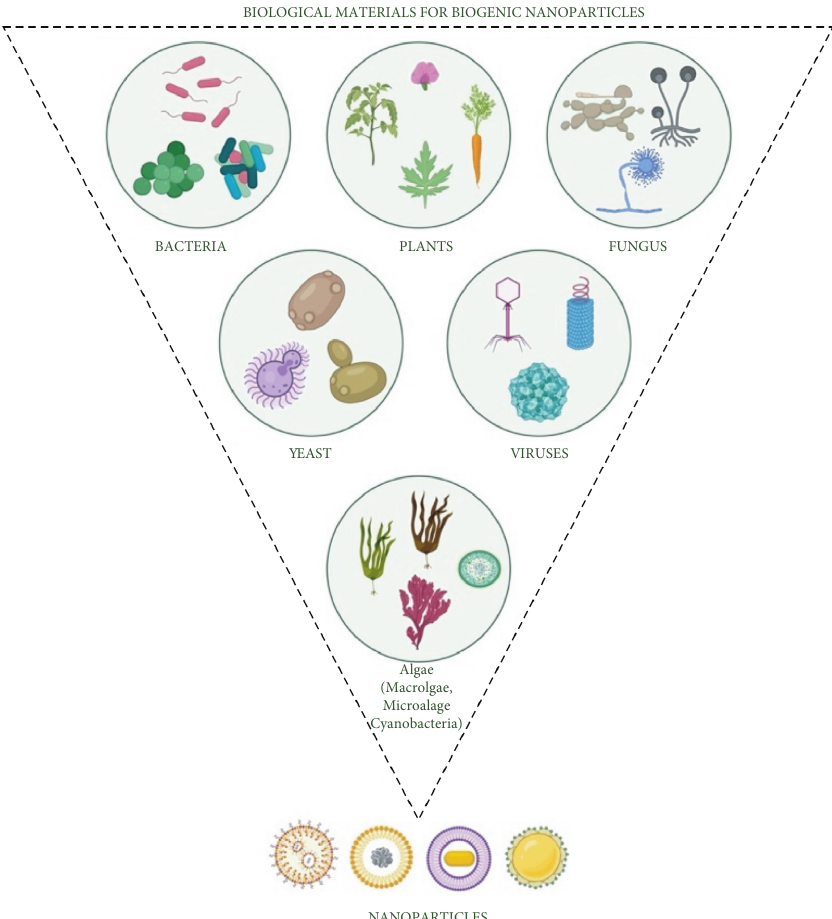
Figure 3: Application of different biological materials for the biogenic synthesis of NPs Created with BioRender.com with publication